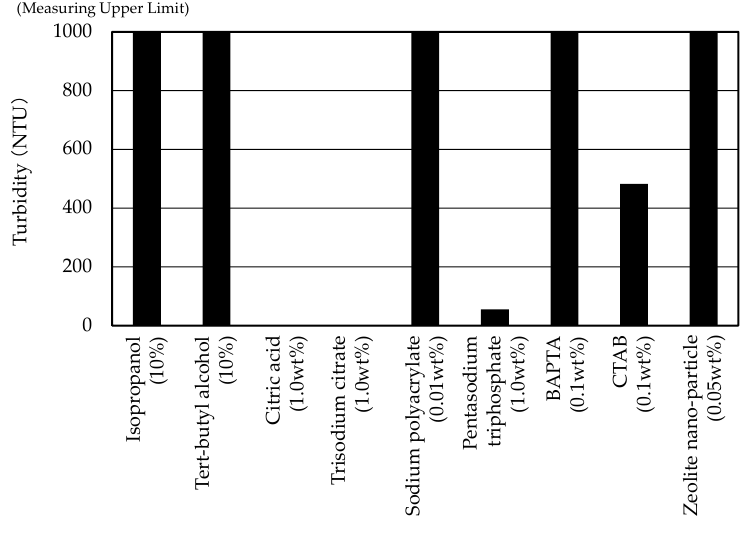
Figure 3. Results of turbidity measurement of the testing solution.